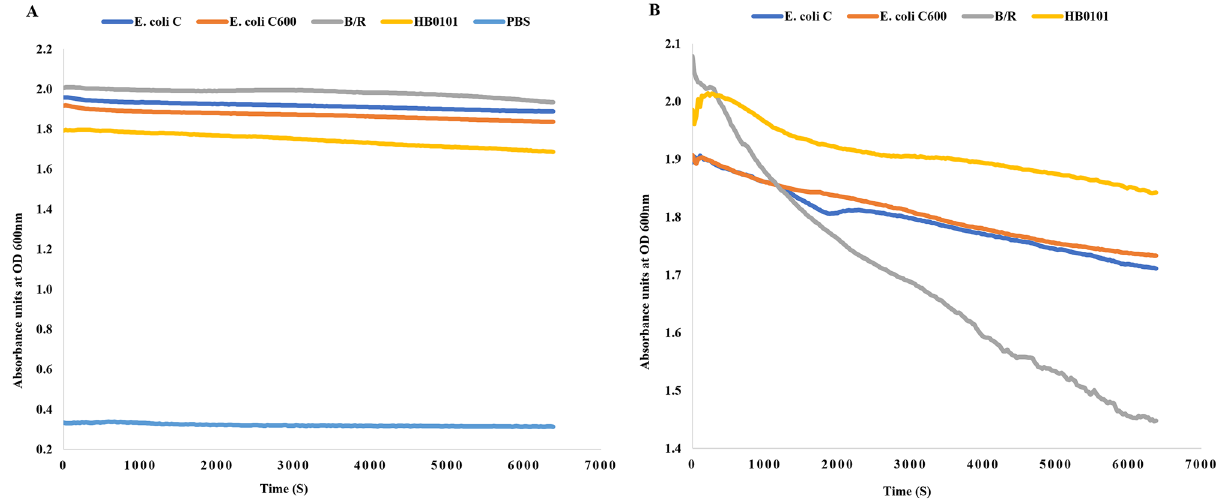
Figure 5. Turbidity reduction assays: ( A ) Escherichia coli strains C, C600, B/R and HB101 in PBS serve as negative controls. ( B ) The same Escherichia coli strains with 80 ng of purified